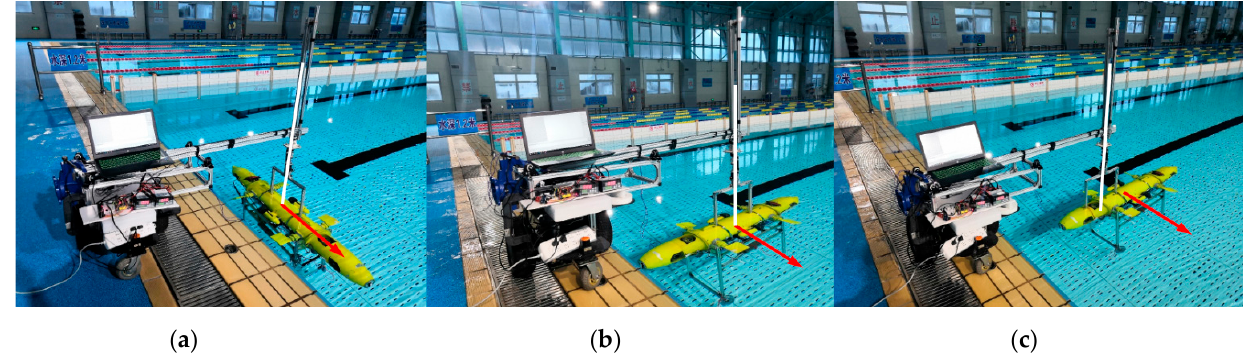
Figure 7. Three sets of experiments. The red arrow in the figure is the movement direction of the underwater robot and the white line is the axis of the force-and-torque-measuring device. ( a , b ) and ( c ) show the experiments in directions of surge, sway and yaw respectively.